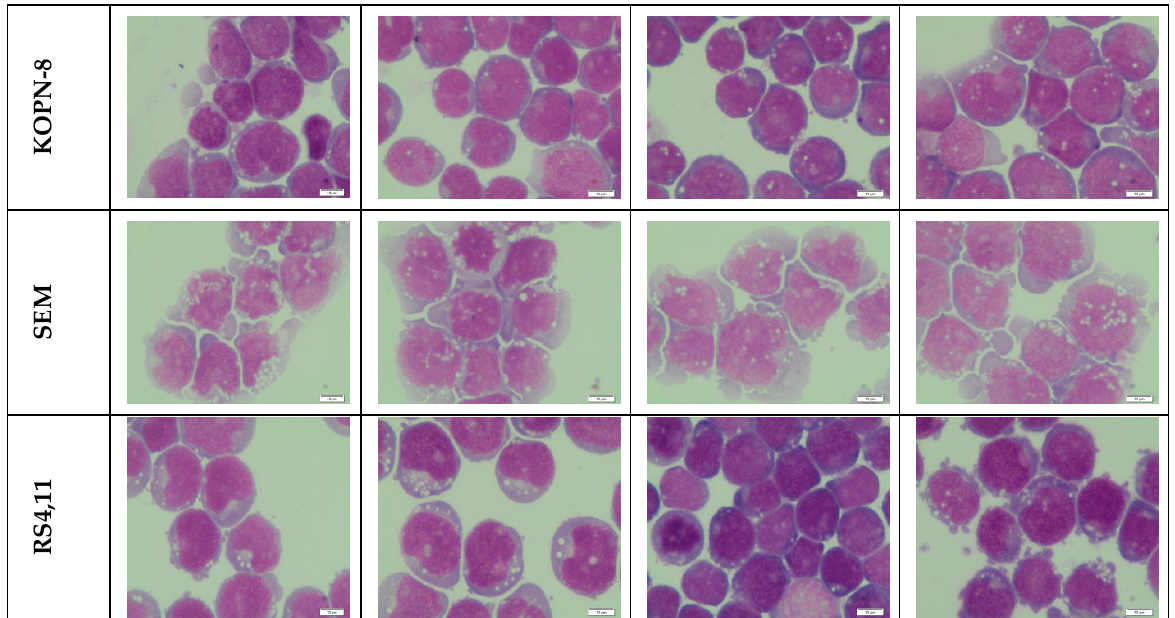
Figure 7. Morphology and kinetics of growth inhibition effect of calcitriol and tacalcitol against B lymphocytes after 24 h/96 h. Notes: ( A ) cluster of cells observed under the inverted microscope with 20× objective (scale bar 20 μ m). Each photograph was captured from two independent repeats. Kinetics of anti-proliferative effects of vitamin D analogs against B lymphocytes were analyzed. Mean values and standard deviation are presented. Each measurement of anti-cytotoxicity effects (at each time point and at each concentration) was performed at least 3 times on independently seeded cells;